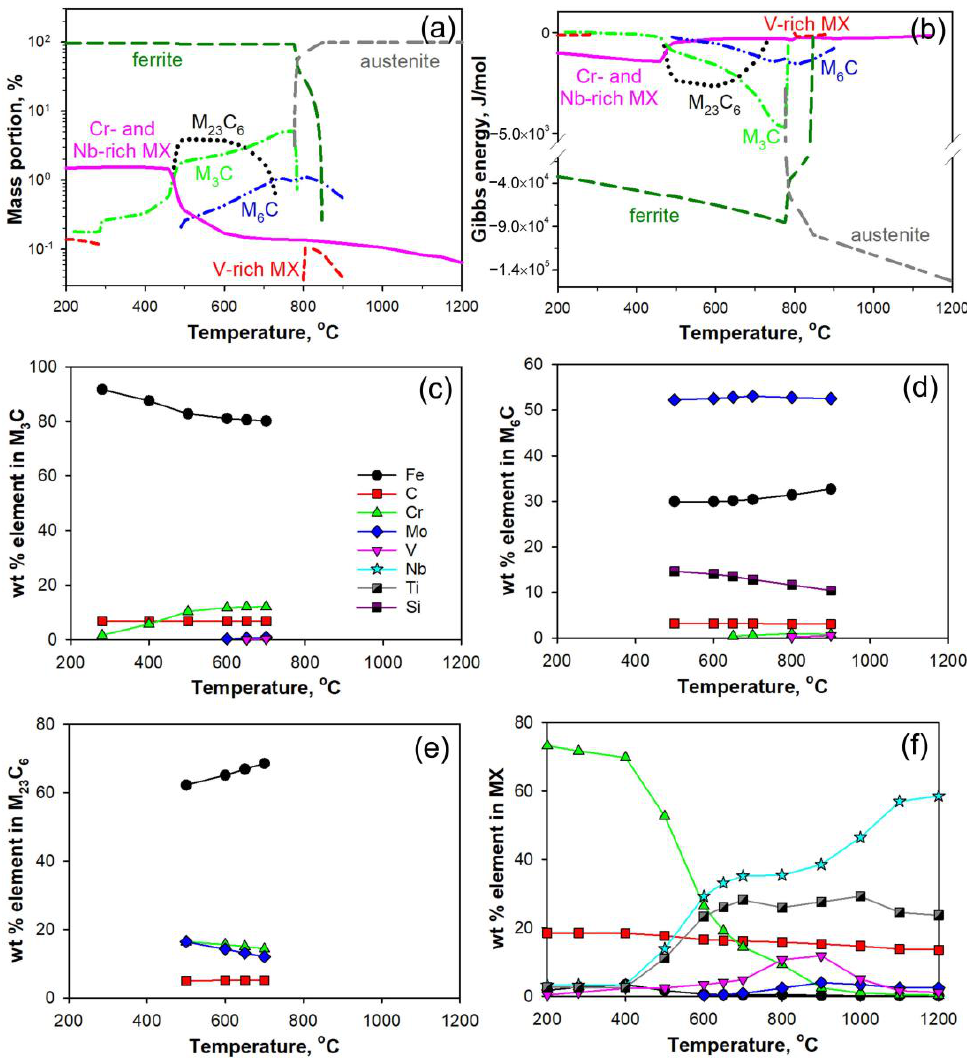
Figure 1. Equilibrium phase diagram of the studied steel: phase fractions ( a ), Gibbs energies ( b ), and the chemical compositions of M 3 C ( c ), M 6 C ( d ), M 23 C 6 ( e ), and MX ( f )